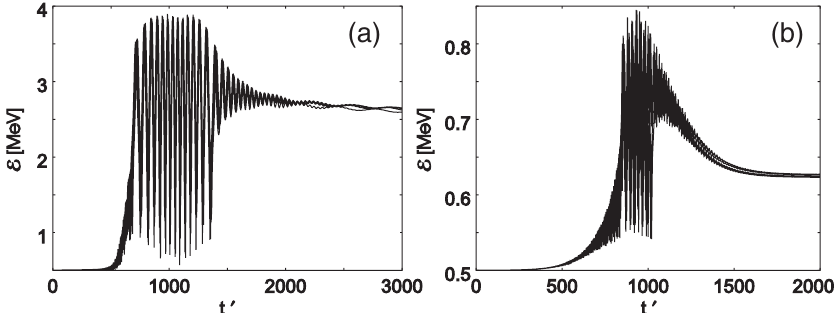
FIG. 3. Reflection capture of the particles from the nonplane counterpropagating laser pulses at different initial longitudinal positions x 0 ( y 0 ¼ z 0 ¼ 0 ): (a) x 0 2 ½(cid:3) (cid:5) 1 ; (cid:5) 1 (cid:2) (with the step 0 : 5 (cid:5) 1 ) for ! 1 =! 2 ¼ 10 , and (b) x 0 2 ½(cid:3) 0 : 4 (cid:5) 1 ; 0 : 4 (cid:5) 1 (cid:2) (step 0 : 2 (cid:5) 1 ) for ! 1 =! 2 ¼ 2 . Other parameters for focused nonplane laser pulses are defined in the text for Fig. 3.